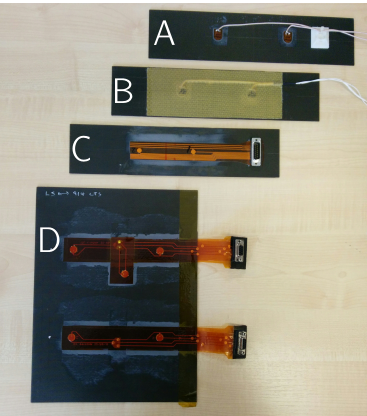
Figure 3. ( A ) DuraAct; ( B ) Co-Bonded; ( C ) Smart Layer; and ( D ) structural health monitoring (SHM) layer.